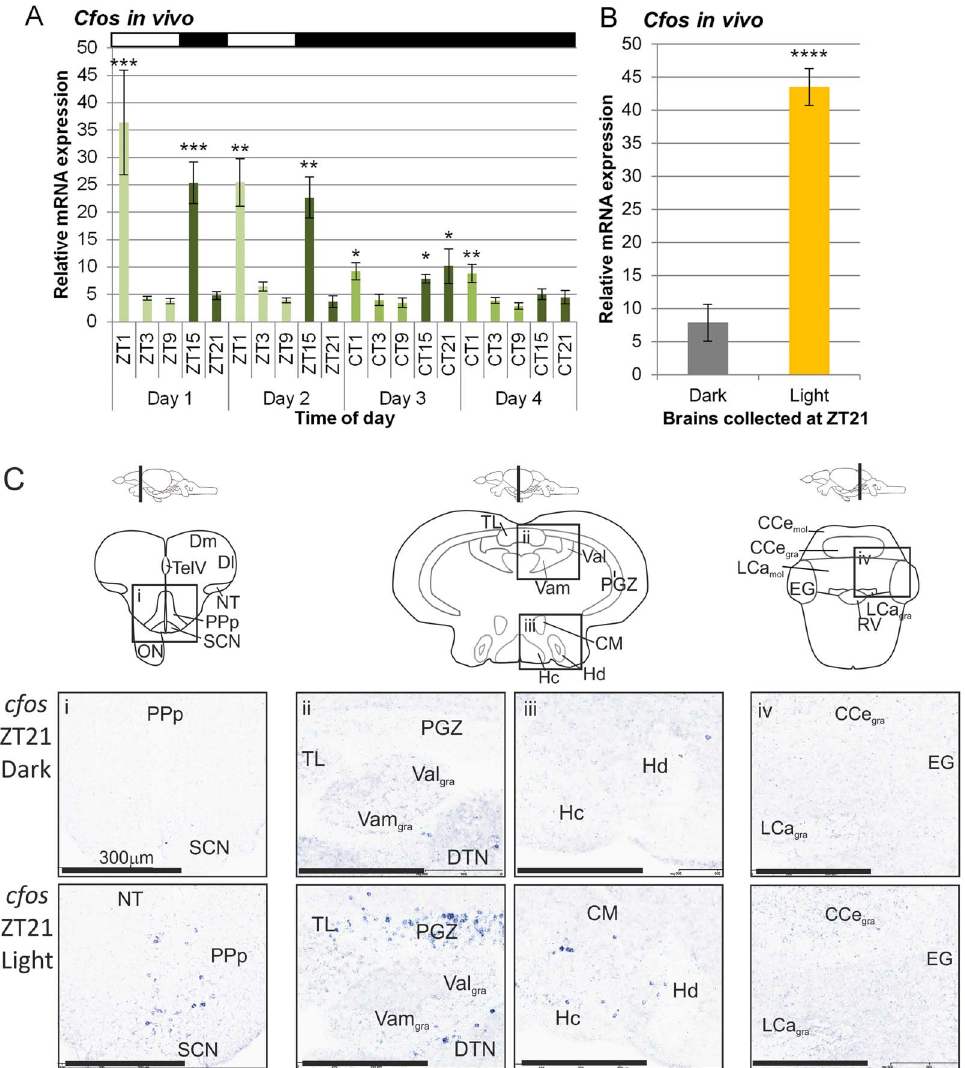
Figure 5. Expression of c-fos in the adult zebrafish brain. A) Zebrafish were kept on 2 days of 14:10 LD followed by 2 days of DD, and brains dissected at the times indicated. RNA was extracted and qPCR was performed to evaluate the relative expression of c-fos mRNA. In LD there was a peak at ZT1 and ZT15 on day 1 and 2, (p , 0.0001, One way ANOVA, n=4–9). The statistical significance is shown from the post-hoc Dunnett’s multiple comparison test, which used the calibrator Day 1 ZT9. In DD there was a peak at CT21 on day 3 and trough at CT9 on day 3 and day 4 (p , 0.001, One way ANOVA, n=4–9). The statistical significance is shown from the post-hoc Dunnett’s multiple comparison test, which used the calibrator CT9 on day 4. The above white and black bars indicate the lighting schedule, and the shades of green reflect the light, dark and subjective dark phases. B) Adult zebrafish on a 14:10LD were given a 30 minute light pulse or kept in the dark at ZT21. Brains were dissected, RNA extracted, and qPCR performed to determine levels of c-fos mRNA as an indicator of neuronal activity. C-fos expression was five-fold higher in the brains of the light pulsed zebrafish (p , 0.0001, unpaired two-tailed t-test, n=7–8). C) c-fos is induced in specific brain regions in response to a light pulse in the night. Adult zebrafish maintained on a 14L:10D LD cycle were exposed to a 30-min light pulse at ZT21 or kept in the dark. In situ hybridisation was performed on brain sections to determine the levels of c-fos mRNA. Regions that show increased c-fos expression in response to light include i) PPp and SCN, ii) TeO, TL, Val gra and Vam gra and iii) Hc and Hd. iv) There is no change in expression in the rhombencephalon. Abbreviations: PPp (dorsal pretectum), SCN (suprachiasmatic nuclei), TeO (optic tectum), TL (torus longitudinalis), Val gra (lateral valvula cerebelli), Vam gra (medial valvula cerebelli), Hc (caudal hypothalamus) and Hd (dorsal